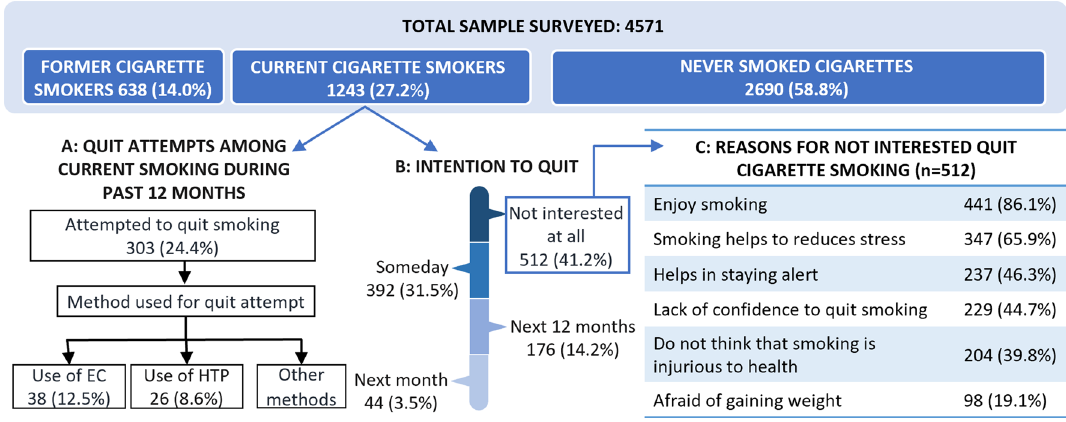
Figure 1. Intentions attempts to quit, and reasons for ‘no intention to quit among current